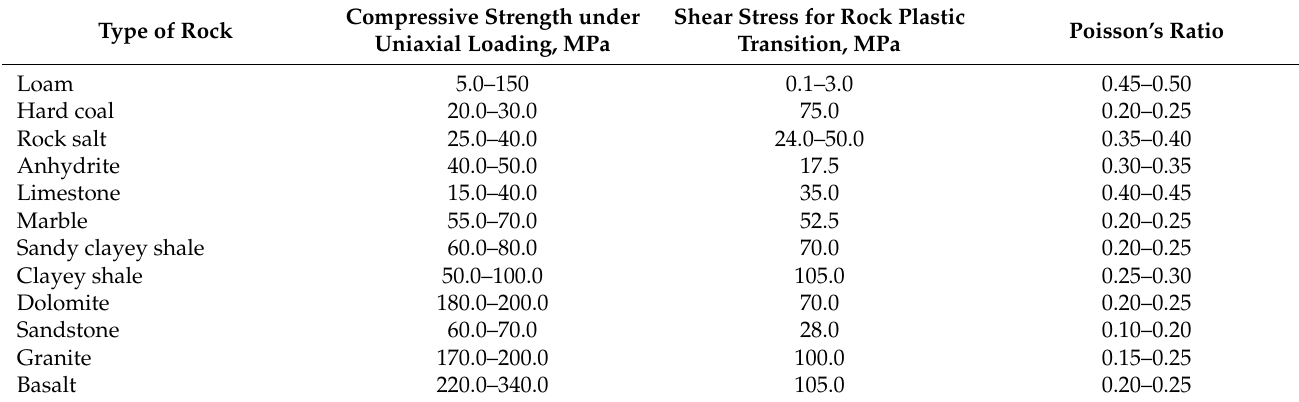
Table 2. Table of rock compressive strength against uniaxial stress